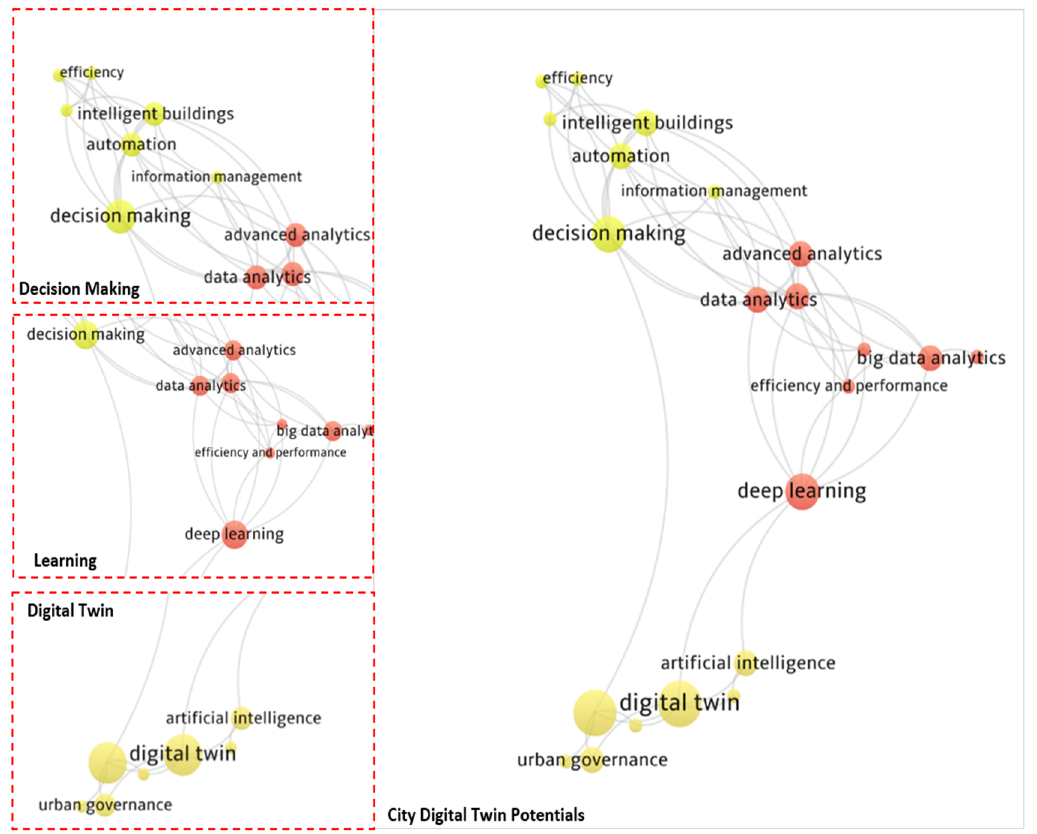
Figure 7. City digital twin potential. Source: Authors.